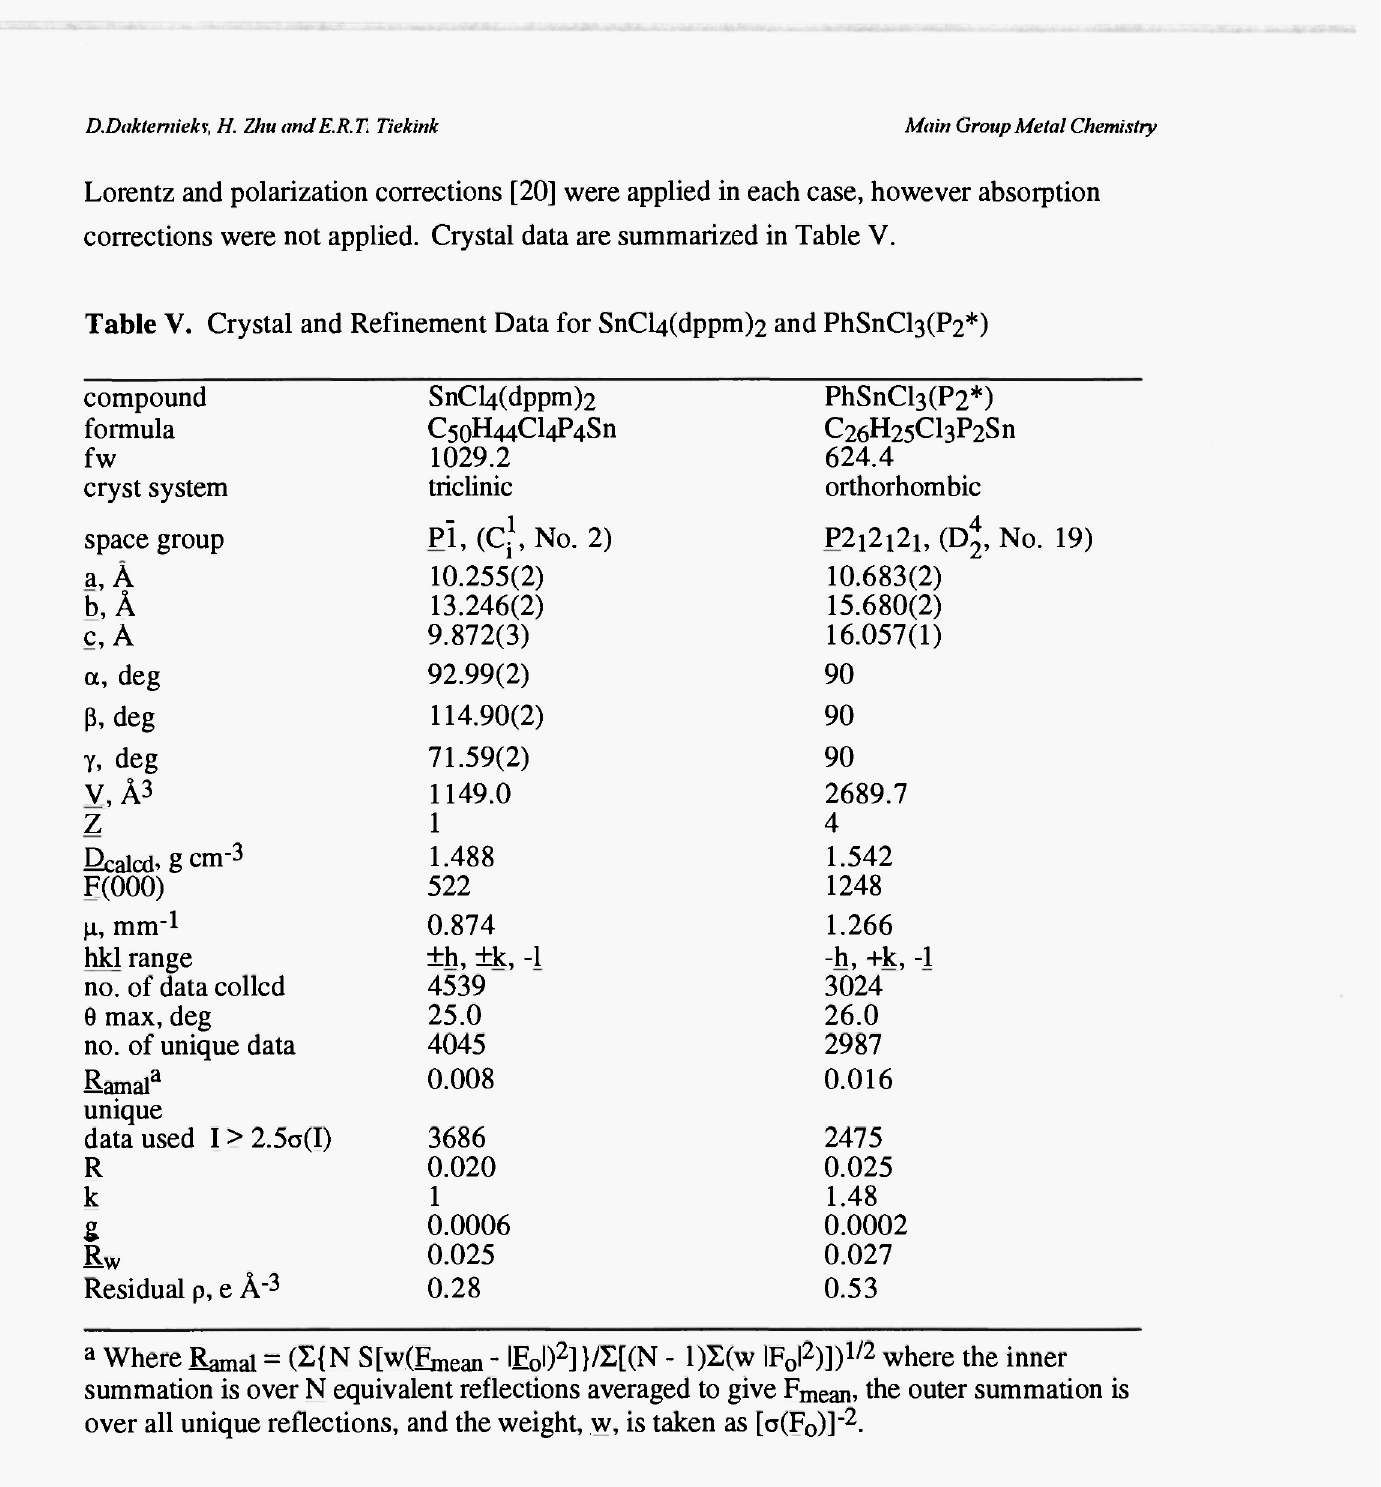
Table V. Crystal and Refinement Data for SnCU(dppm )2 and